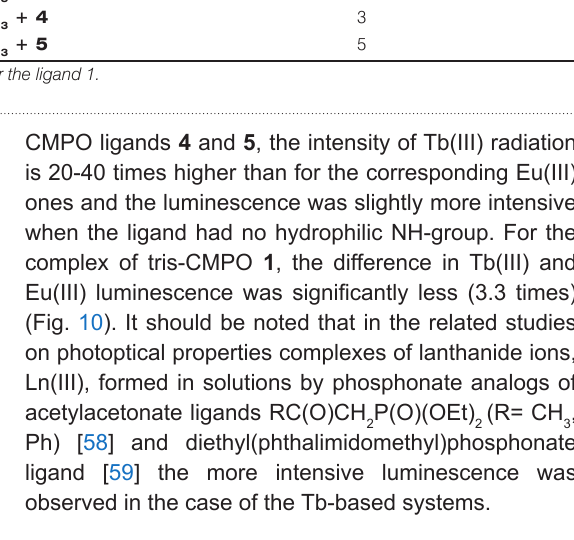
Table 4. Luminescence of europium and terbium complexes in solutions with 1:10 Ln(III):L ratio (C Solutions a Tb(III)